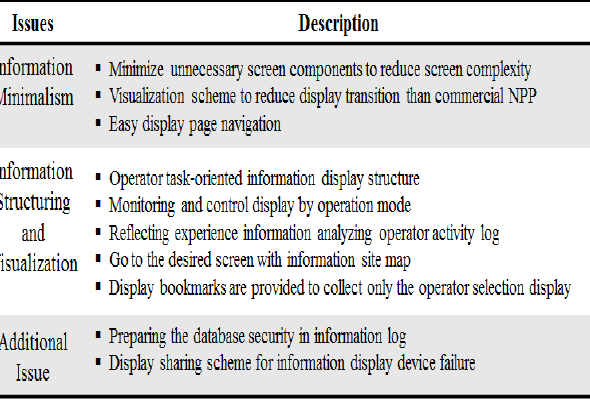
Fig. 2. Design Ideas and Issues